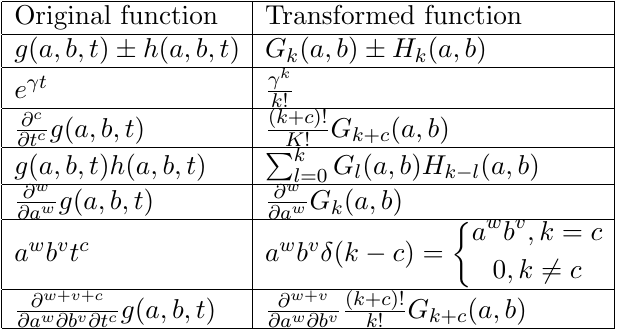
Table 1. The operations for the re- duced differential transform